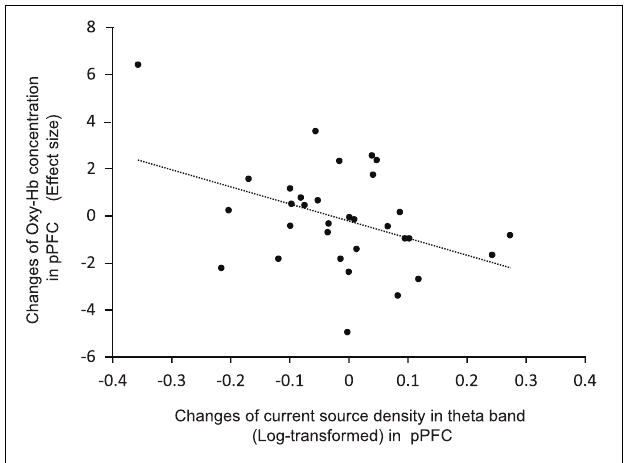
FIGURE 7 | Relationships between changes in effect sizes of NIRS hemodynamic responses and changes in log-transformed CSD of EEG theta oscillations in the pPFC during compression.